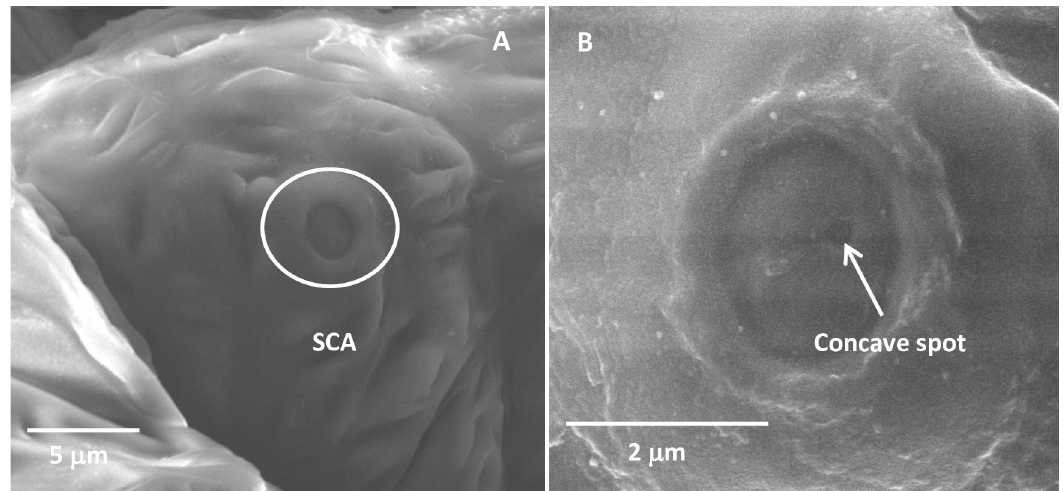
Fig 7. Sensilla campaniform in fourth-instar Diaphorina citri nymphs. (A) Sensilla campaniform on the second segment of the antennae. (B) Sensilla campaniform, showing the concave spot. SCA, sensilla campaniform.